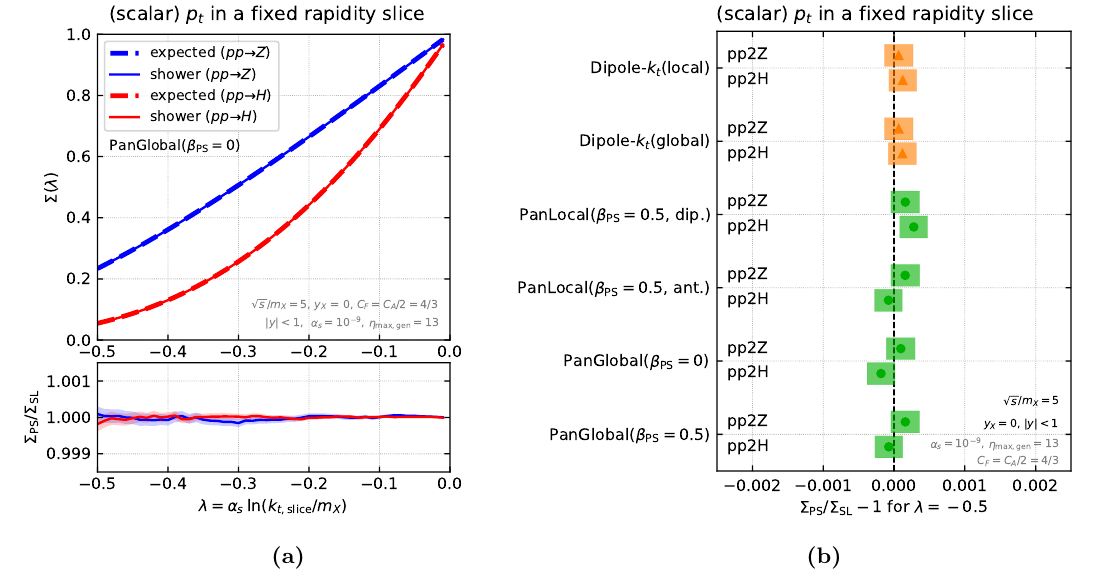
Figure 7. (a) Cumulative distribution for the transverse-momentum in a rapidity slice of | y − y X | < 1 as a function of λ for the PanGlobal β ps = 0 shower. The top panel shows the expected (dashed) and the shower (solid) results, and the bottom panel shows the ratio between the two. (b) Difference between the shower Σ PS and the expected single-logarithmic result ( Σ SL ) for a fixed value of λ = − 0 . 5 for all showers. Colour coding is the same as in figure